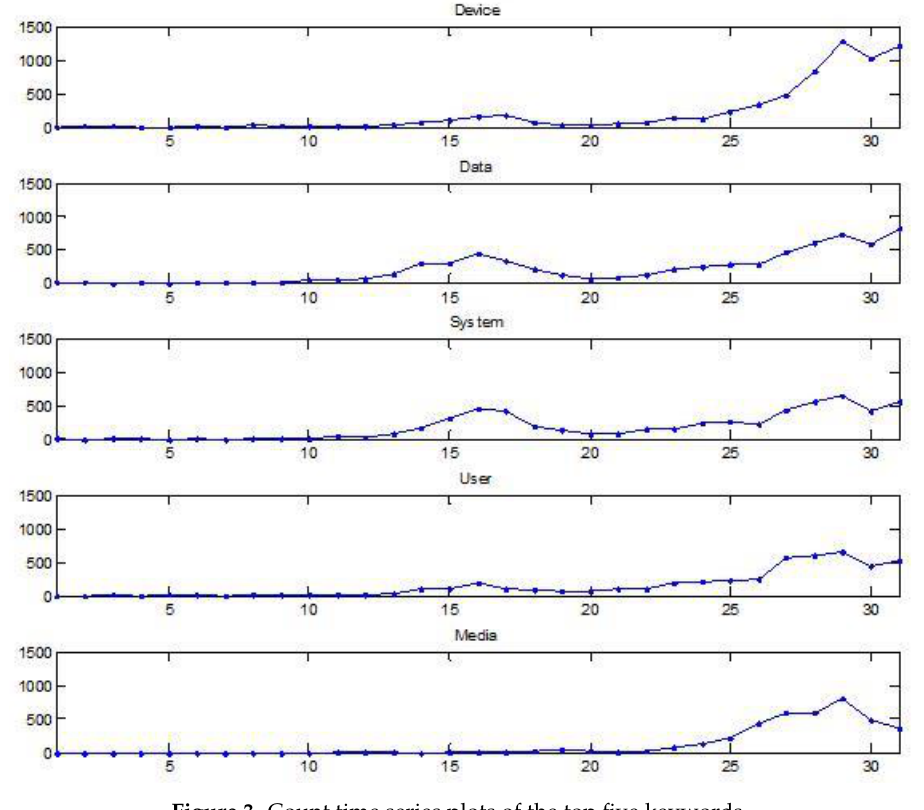
Figure 3. Count time series plots of the top five keywords.